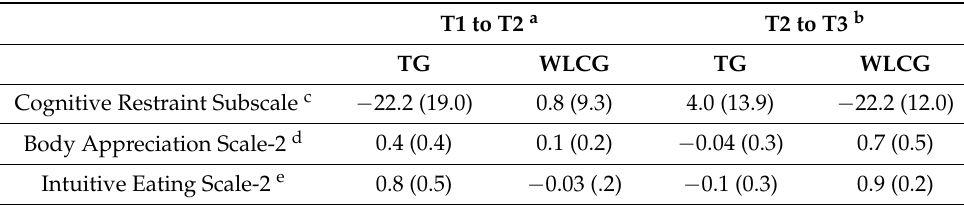
Table 2. Means and standard deviations (SD) of difference scores for cognitive restraint, body appreciation, and intuitive eating across assessment timepoints for the treatment group (TG; n = 7) and the waitlist control group (WLCG; n = 7). T1 to T2 a T2 to T3 b TG WLCG TG WLCG Cognitive Restraint Subscale c − 22.2 (19.0) 0.8 (9.3) 4.0 (13.9) − 22.2 (12.0) Body Appreciation Scale-2 d 0.4 (0.4) 0.1 (0.2) − 0.04 (0.3) 0.7 (0.5) Intuitive Eating Scale-2 e 0.8 (0.5) − 0.03 (.2) − 0.1 (0.3) 0.9